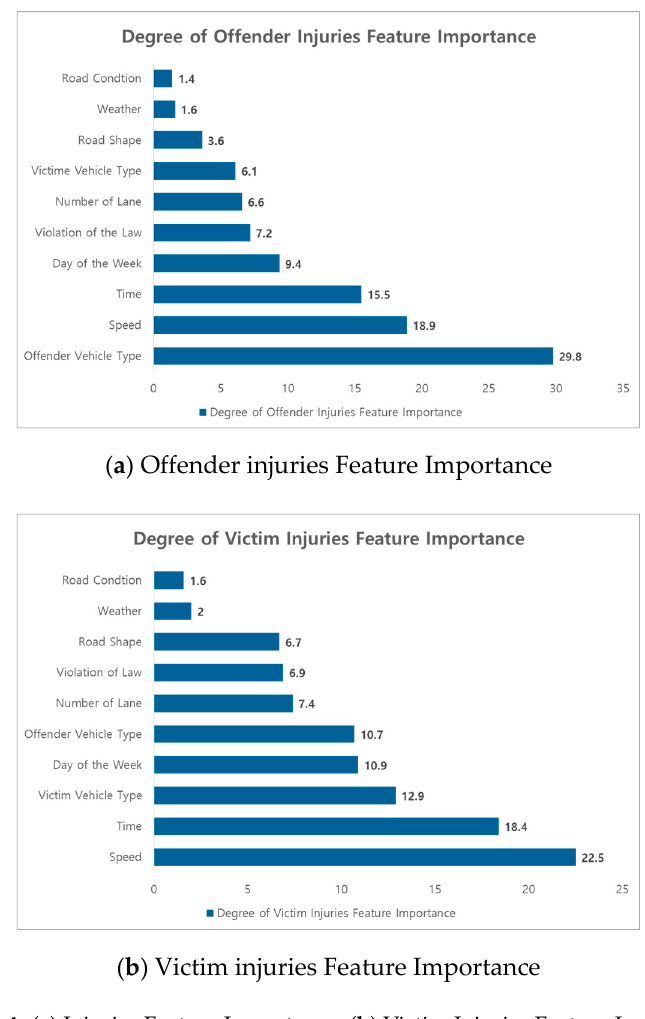
Figure 4. ( a ) Injuries Feature Importance; ( b ) Victim Injuries Feature Importance Table 8. Result of Importance Analysis for Traffic Accident Factors.